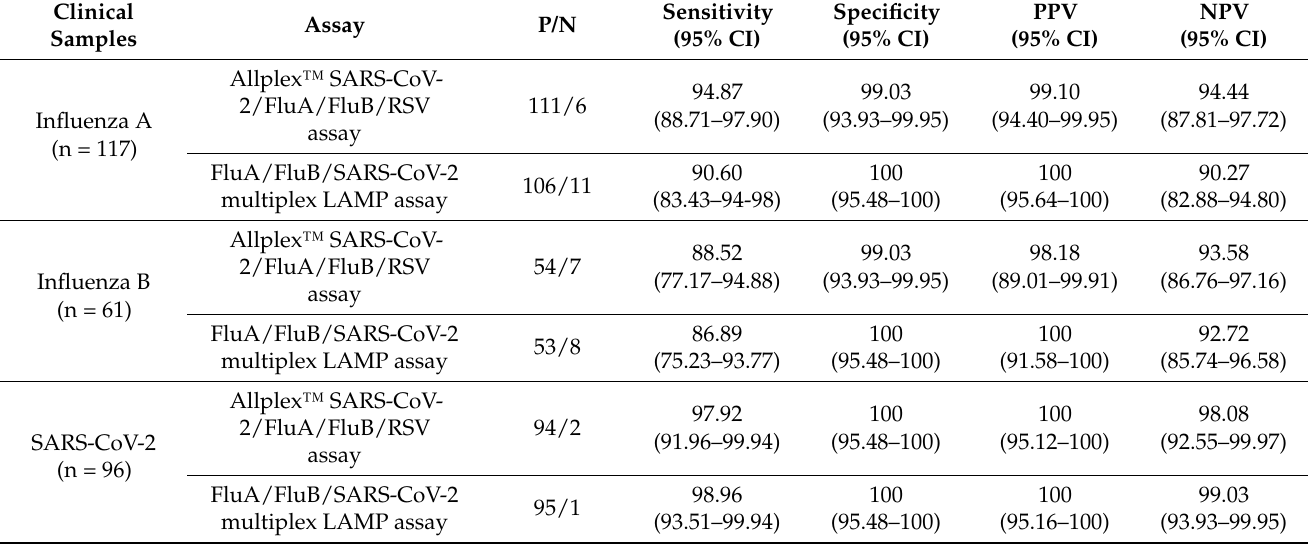
Table 5. Comparison of performance of the FluA/FluB/SARS-CoV-2 multiplex LAMP assay